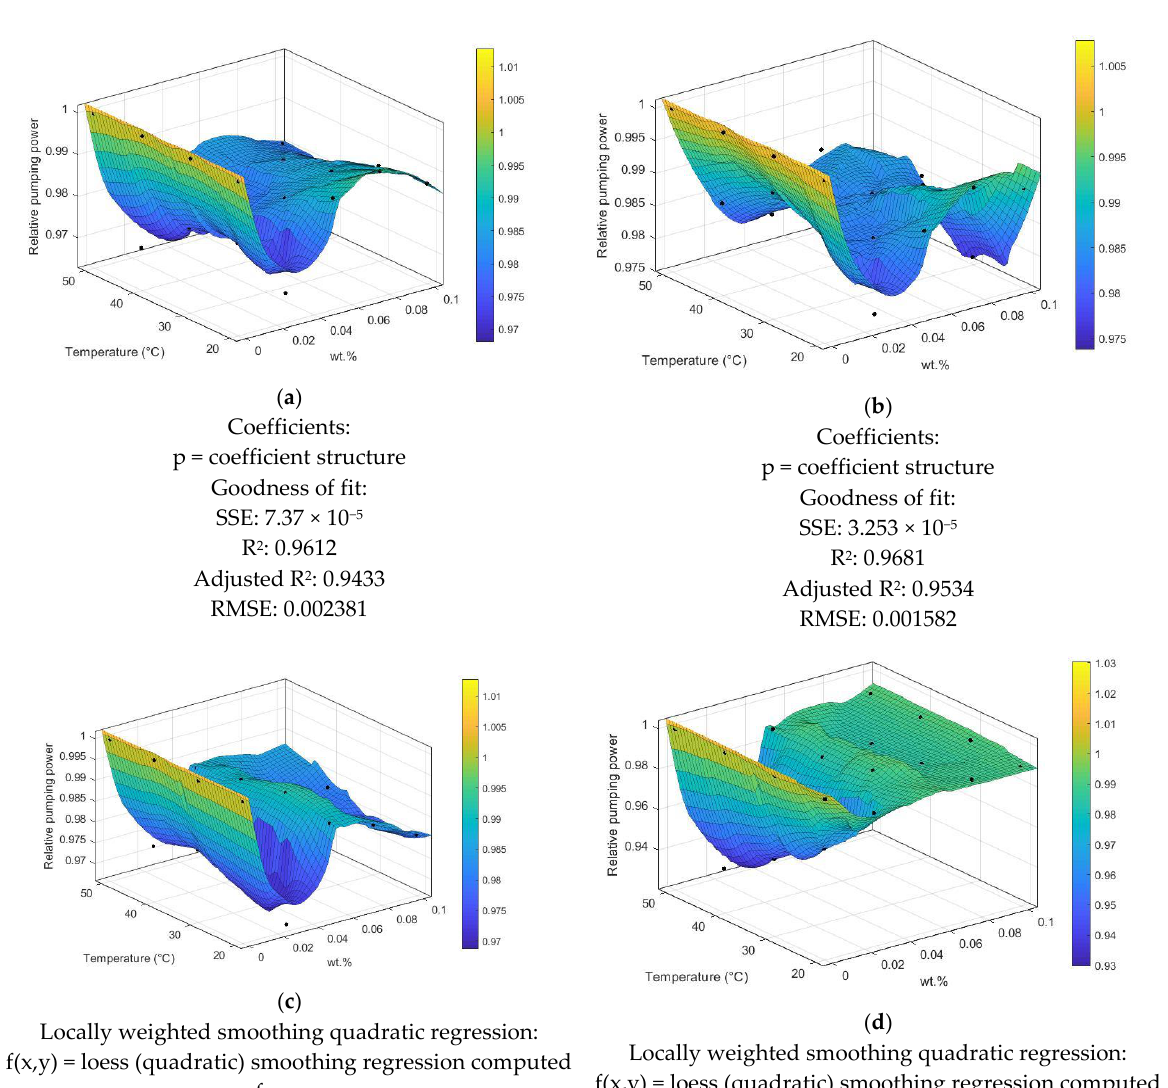
f(x,y) = loess (quadratic) smoothing regression computed where x is normalized by mean 0.05 and std 0.03627 and where y is normalized by mean 35 and std 11.47